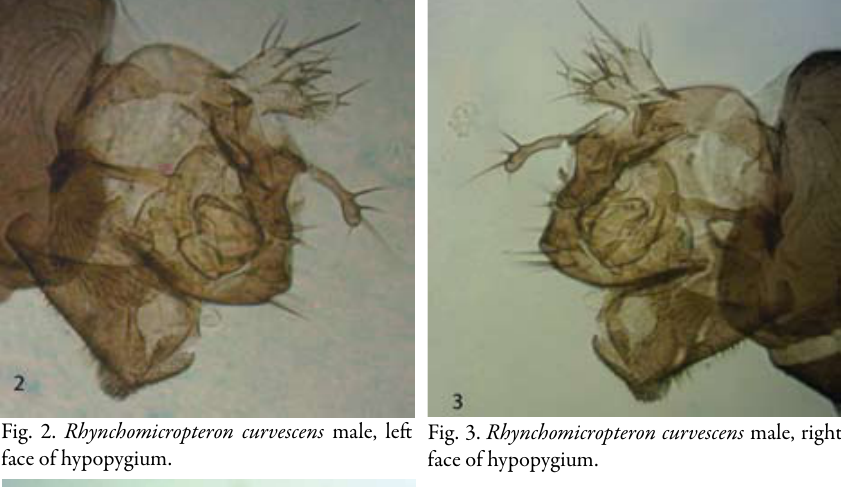
Fig. 3. Rhynchomicropteron curvescens male, right face of hypopygium.